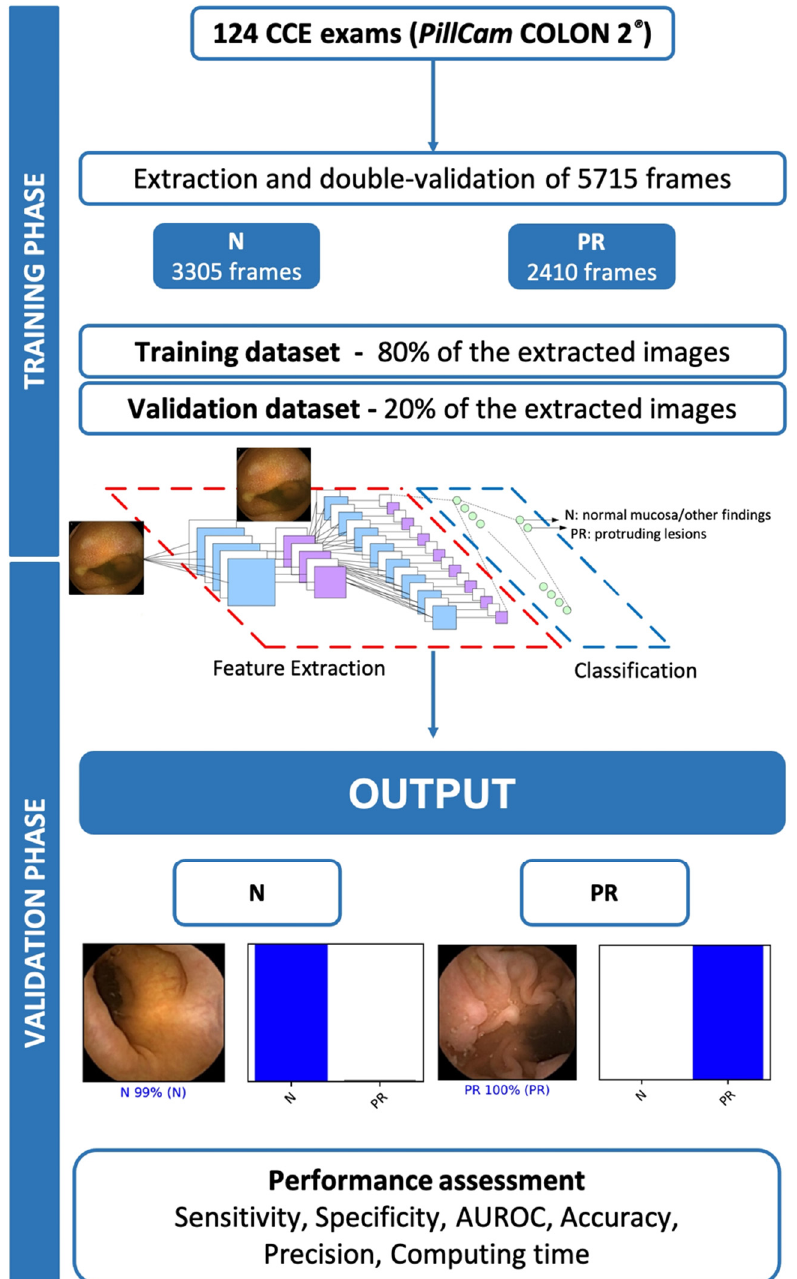
Figure 1. Summary of study design for the training and validation phases. PR—protruding lesion; N—normal mucosa or other findings.